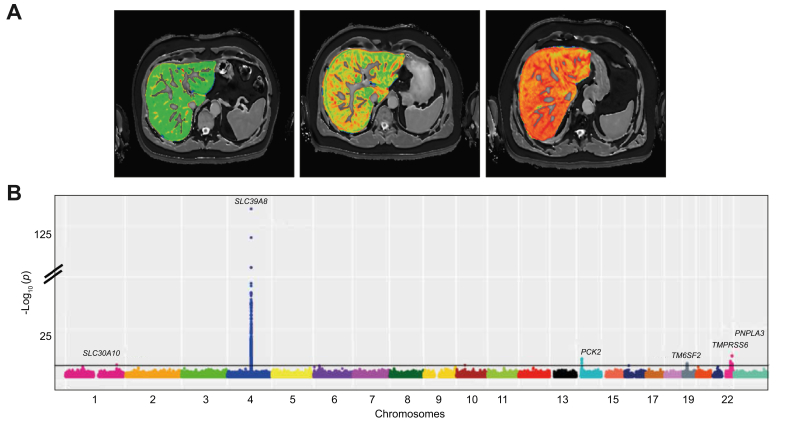
GWAS of liver cT1 in the UK Biobank.(A) Liver MRI scans of cT1. Three selected cases of liver MRI scans showing, from left to right, progressively elevated cT1 values (671 ms, 777 ms, 917 ms), reproduced by kind permission of UK Biobank©. (B) Manhattan plot illustrating GWAS of liver cT1 measurements in 14,440 UK Biobank individuals (~12 million imputed variants). The x-axis is the chromosomal position and y-axis is the significance of association for each variant in log10(p values). Grey line indicates genome-wide significance level. For the GWAS, a linear mixed model was used. Levels of significance: p <5×10−8. cT1, corrected T1; GWAS, genome-wide association study. (This figure appears in color on the web.)